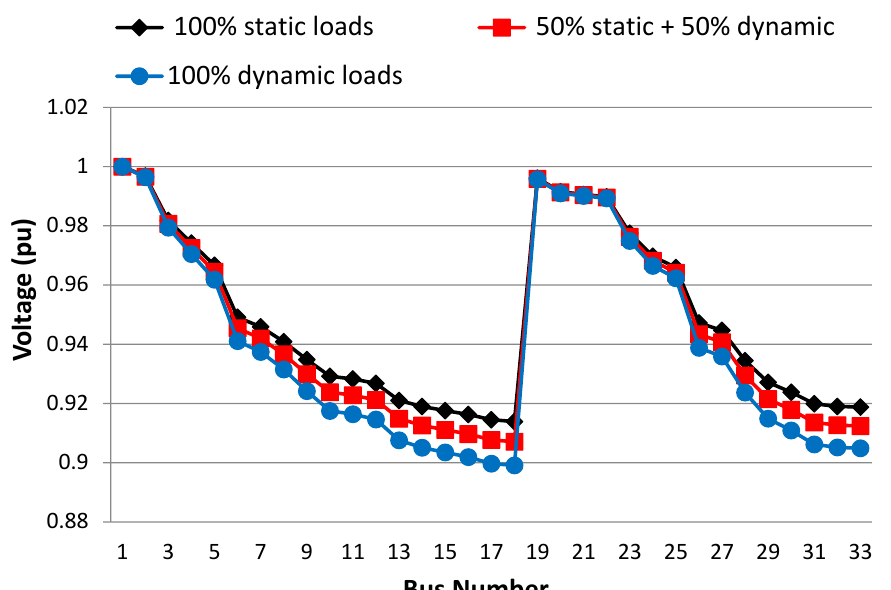
Figure 5. Effect of load type on voltage profile at 100% loading. This effect is not only at 100% loading but also appears in 150% loading cases, as shown in Table 2, proving that the drop in the voltage is clearer when adding extra loads. The voltage is reduced to 0.876 pu at 100% static load and to 0.861 pu at 50% static 50% dynamic, and also at 100% dynamic is 0.841 pu, and it is affected by the extra load that appears on power losses more than the other case, case number one (100% loading). The voltage at each bus for all cases appears in Figure 6. Table 2. Comparison between static and dynamic loads at 150% loading, i.e., a total load of (5370 + j2617) kVA.